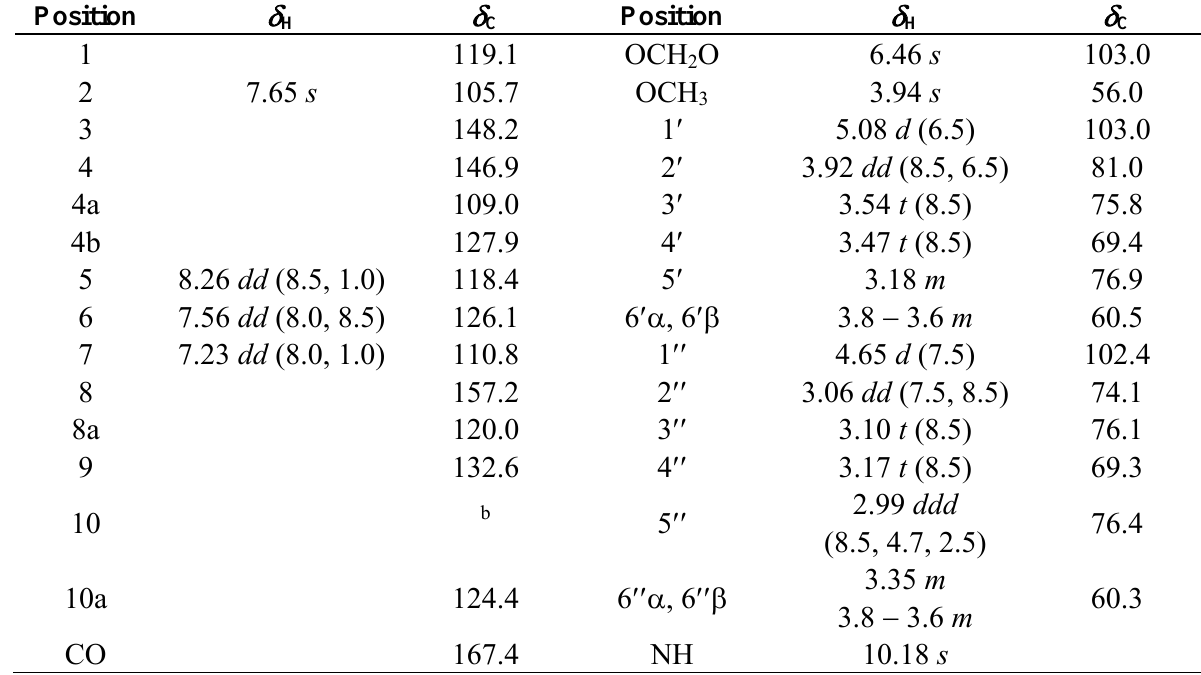
Table 1. NMR data for compound 10 .